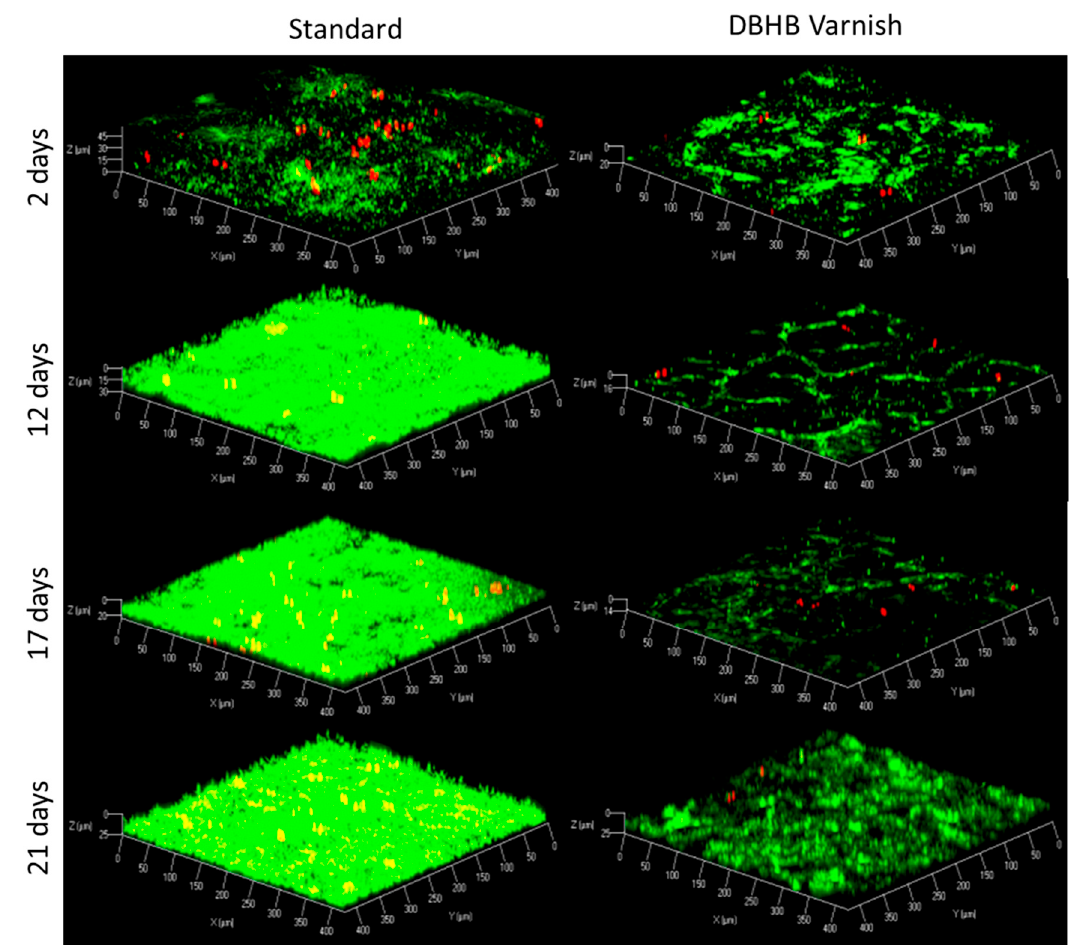
Figure 7. CLSM photography of microfouling developed on varnishes containing DBHB (DBHB varnish) and without DBHB (standard) during in vitro immersion. The mixed cultures were realized in PBR. Color allocation: red, autofluorescence of chlorophyll; green (Syto 9), bacteria; yellow: overlay of microalgae and bacteria Int. J. Mol. Sci. 2017 , 18 , 1520